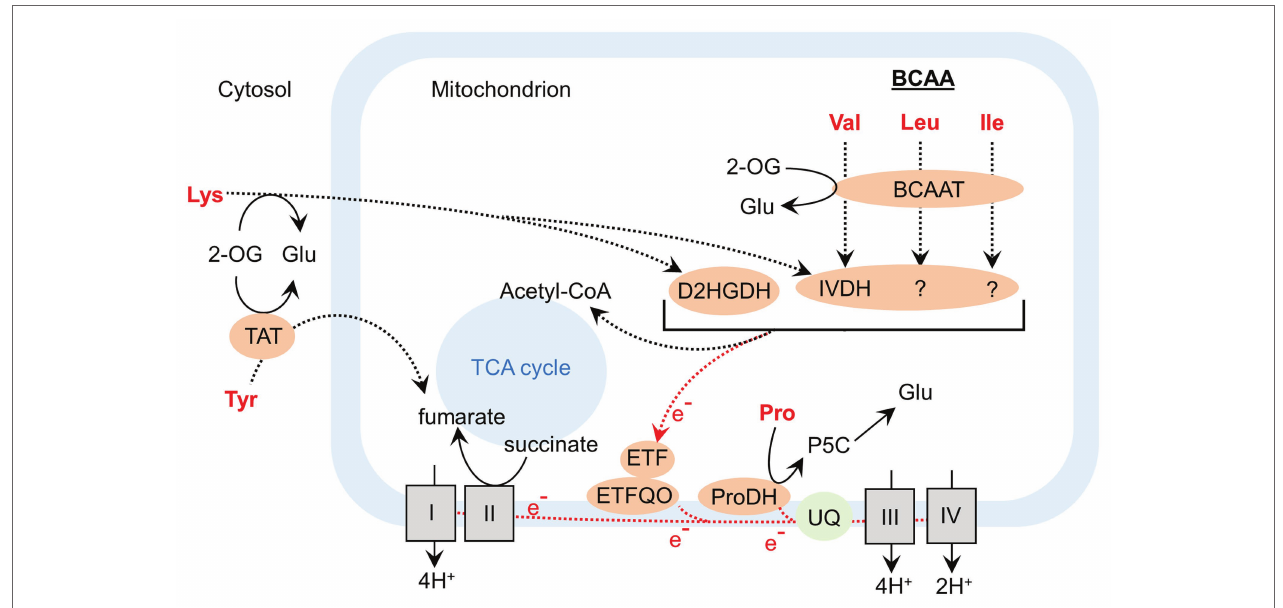
FIGURE 2 | Contribution of amino acid catabolism to the activity of the tricarboxylic acid cycle and to the mitochondrial electron transfer chain during dark-induced senescence in Arabidopsis . BCAAT, branched-chain amino acid aminotransferase; D2HGDH, D-2-hydroxyglutarate dehydrogenase; ETF, electron-transfer flavoprotein; ETFQO, electron-transfer flavoprotein:ubiquinone oxidoreductase; IVDH, isovaleryl-CoA dehydrogenase ProDH, proline dehydrogenase; P5C, 1-pyrroline-5-carboxylic acid; TAT, tyrosine aminotransferase; TCA, tricarboxylic acid; UQ, ubiquinone; 2-OG,